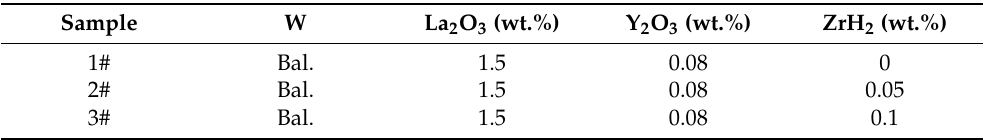
Table 1. The composition of the